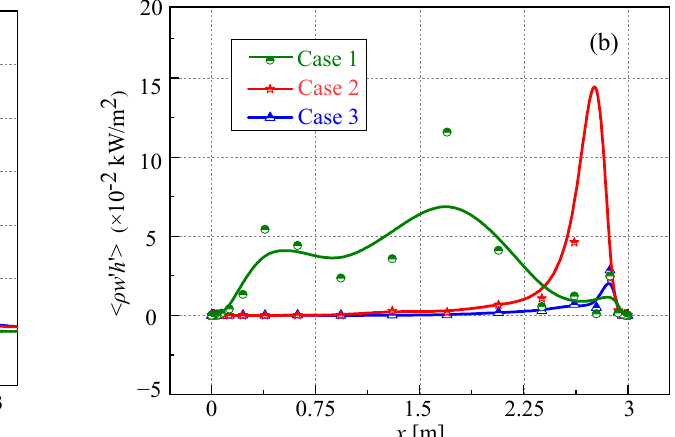
Figure 11. Thermal statistics of the selected cross-sectional planes along the x -axis in Case 1, Case 2, and Case 3: ( a ) variations in turbulent heat flux along the x -direction; ( b ) variations in turbulent heat flux along the y -direction.